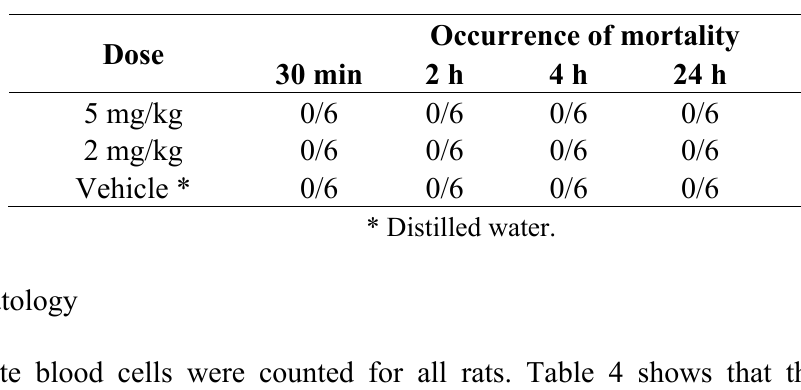
Table 3. The observation data for toxicology study of adiponectin.